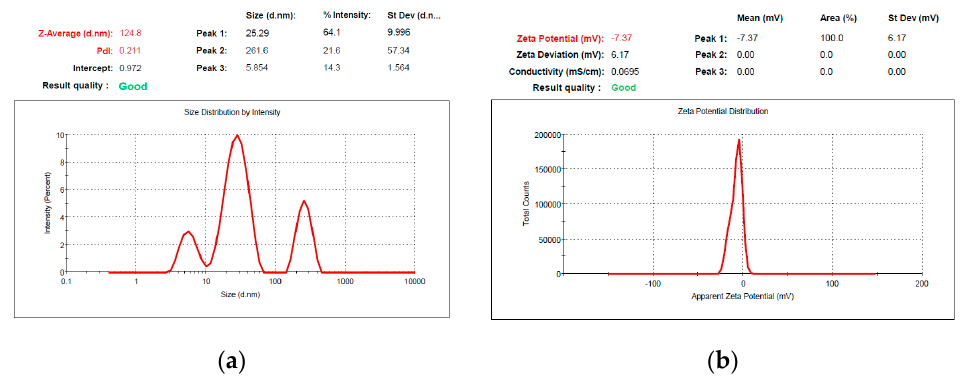
Figure 1. Size distribution ( a ) and zeta potential ( b ) for Pluronic P123 micellar dispersion loaded with Curcumin.